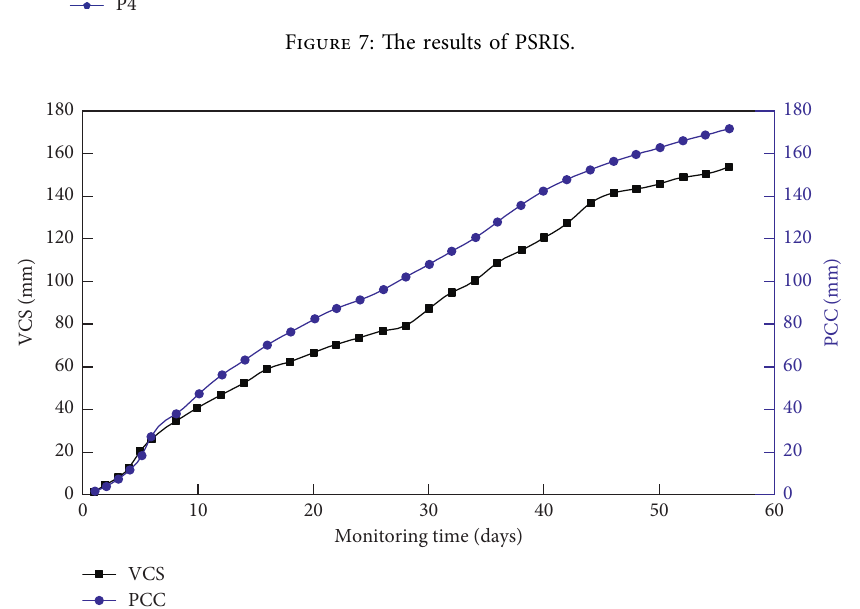
Figure 8: The results of the PCC and VCS.